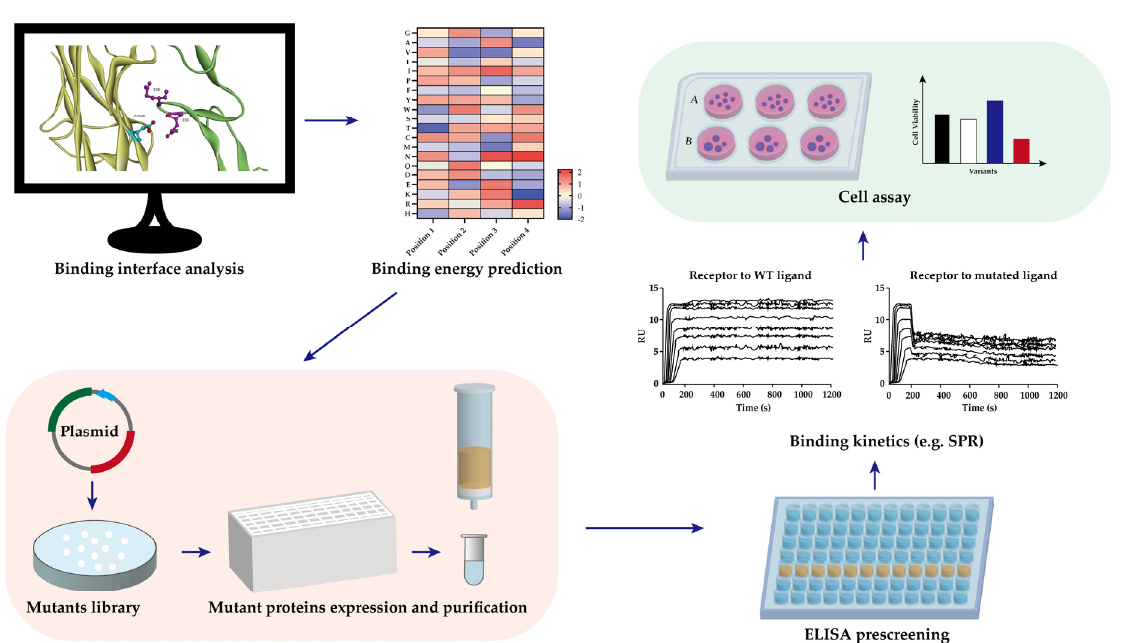
Figure 3. General workflow of computer-aided protein engineering, which helps the design and optimization of the target